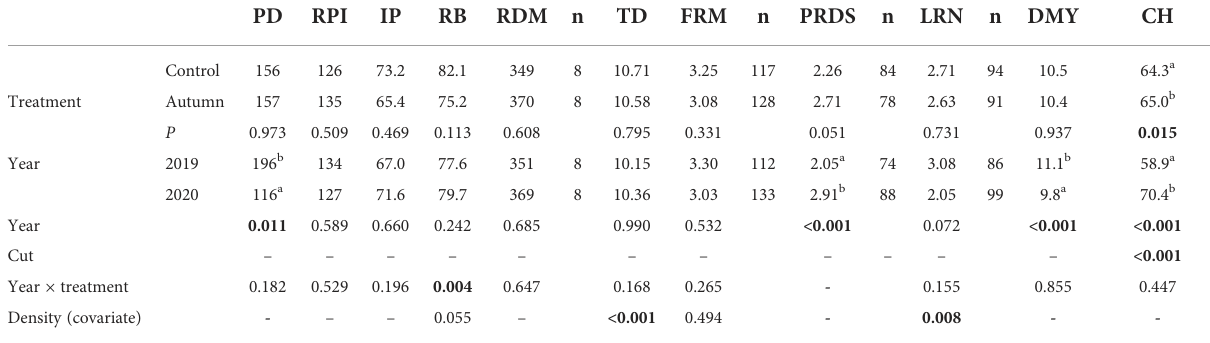
TABLE 5 Effect of treatment and third and fourth harvest year for Site 3 (Drva ́ lovice) on lucerne plant density (PD, plant m -2 ), root potential index (RPI), ratio of infected plants (IP, as %), ratio of branch-rooted plants (RB, as %), total root dry matter (RDM, g m -2 ), tap root diameter (TD, mm),